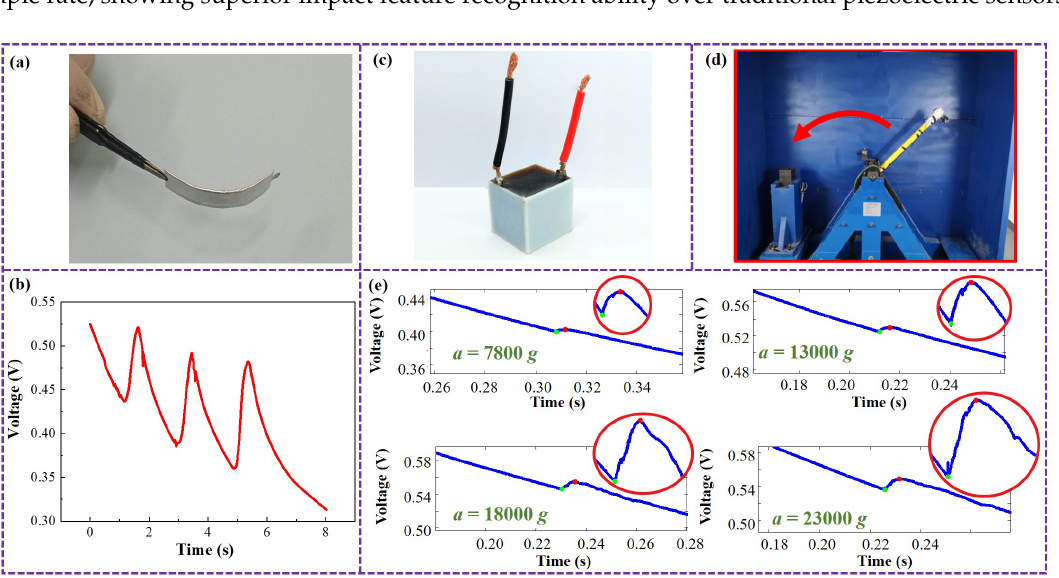
Figure 5. Applications as self-powered mechanical sensors. ( a ) The flexible pressure sensor device. ( b ) Response signal of the pressure sensor under continuous pressing. ( c ) The impact sensor device. ( d ) The Machete Hammer system. ( e ) Response signal of the impact sensor under different accelerations of